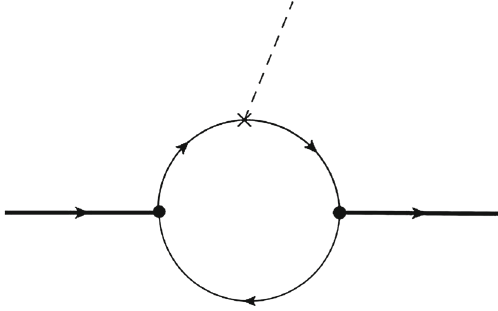
Fig. 1 The Feynman diagram for the matrix element